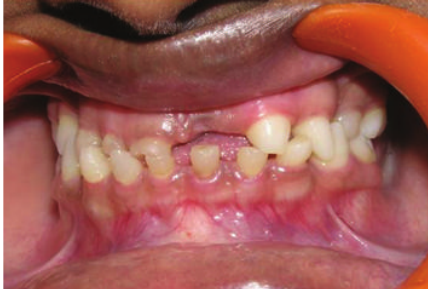
Figure 2: Severely attritted mixed dentition resulting in a collapsed